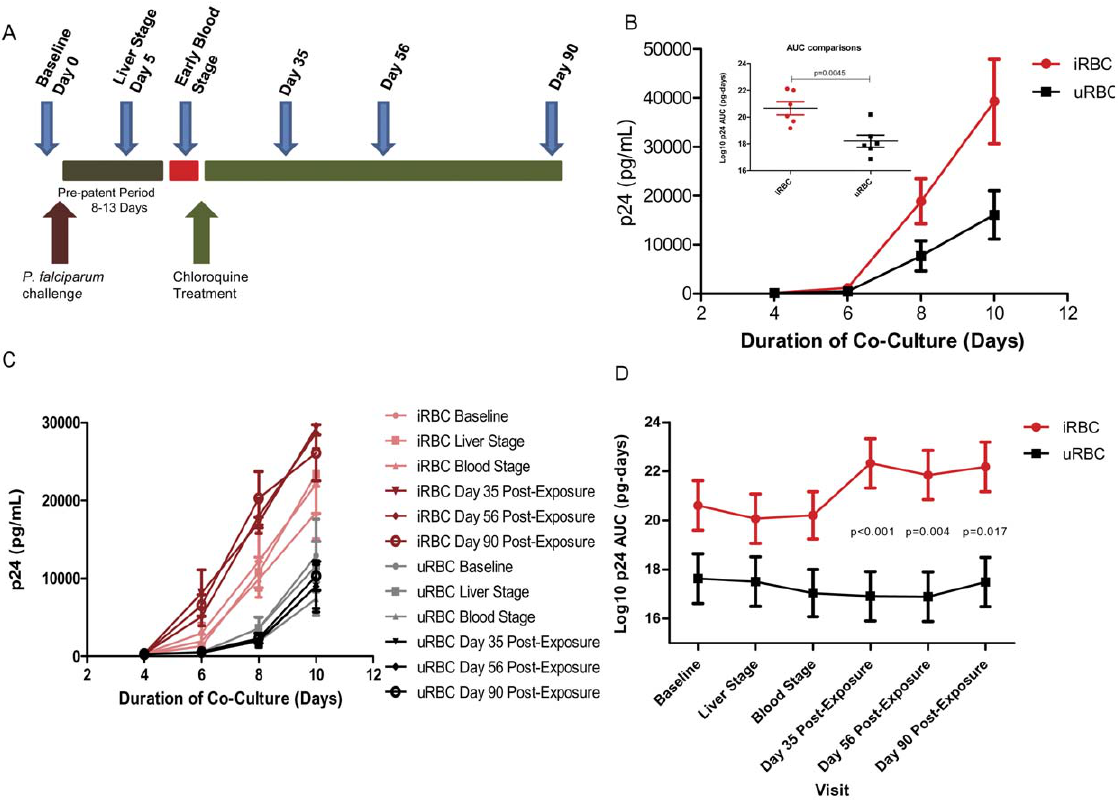
Figure 1. Plasmodium falciparum enhances HIV-1 production. A. Schematic representation of controlled P. falciparum infection. B. HIV production, as measured by p24 antigen concentration in the supernatants from PBMCs co-cultured with P. falciparum infected (iRBC, red line) or uninfected red blood cells (uRBC, black line). Inset shows area under the curve (AUC) comparisons of the amount of HIV p24 Ag produced in the iRBC versus uRBC co-cultures for 6 naı¨ve donors averaged in the graph (Error bars represent SEM, p-value was determined with a paired two-tailed T-test). C. HIV production from PBMCs that were isolated at the 6 different visits from study participants and placed into co-culture with either iRBCs or uRBCs. Pink and black lines represent the means for the 5 participants (the blood stage time point included only 4 participants) at the three earliest time points (D0, D5, day of first parasitemia) and the burgundy and grey lines represent the means of the convalescent time points ( , D35, D56, D90), error bars represent the SEM. D. AUC comparisons of HIV production from the iRBC (red) and uRBC (black) co-cultures at all 6 visits. HIV production in the iRBC co-cultures is greater than the HIV production in the uRBC co-cultures at each visit; HIV produced in iRBC post-exposure co-cultures is greater than that produced in the iRBC co-cultures at the 3 early visits (p , 0.001 day 35, p=0.004 day 56, and p=0.017 day 90 post-exposure). Each point is the mean for the 5 donors at that visit; the error bars represent the 95% confidence interval. p-values were determined using a repeated measures ANOVA, corrected for multiple